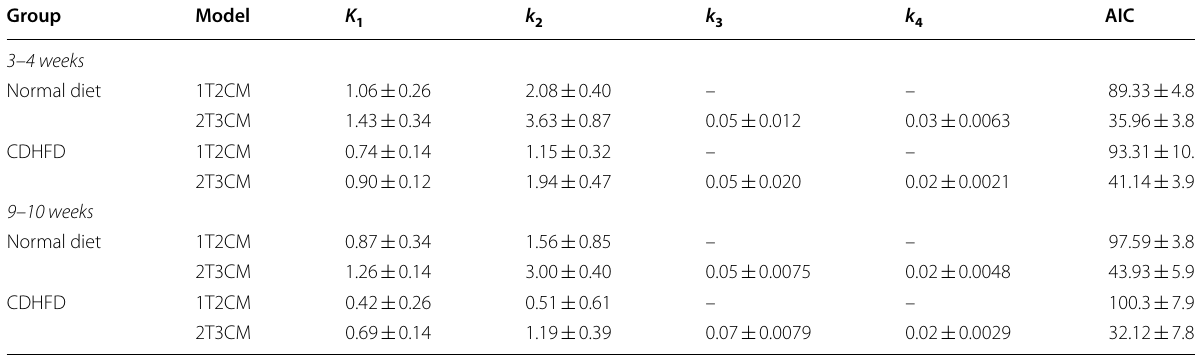
Values are expressed as means